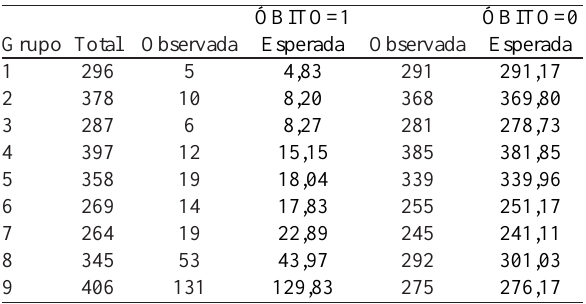
Tabela 5. Mortalidade observada e esperada mediante uso do ES como variável preditora nos grupos definidos pelo teste Hosmer –